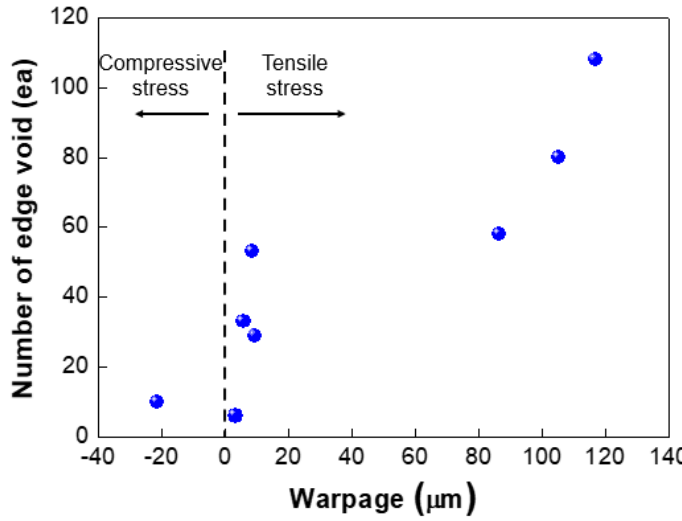
Figure 11. Relationship between number of edge voids and wafer warpage. During the bonding process, the top wafer was loaded in an upside-down position into the vacuum chuck. As shown in Figure 10a, the top wafer was originally deformed in a concave shape due to the tensile residual stress of the film. During the bonding process, the top wafer with a concave shape was loaded face-down (e.g., convex shape) into the top vacuum chuck. For bonding, the vacuum was applied to both wafers, and the deformed wafers became flat. The center contact pin was then loaded onto the top wafer to come into contact with the bottom wafer, and the vacuum at the wafer edge was released.